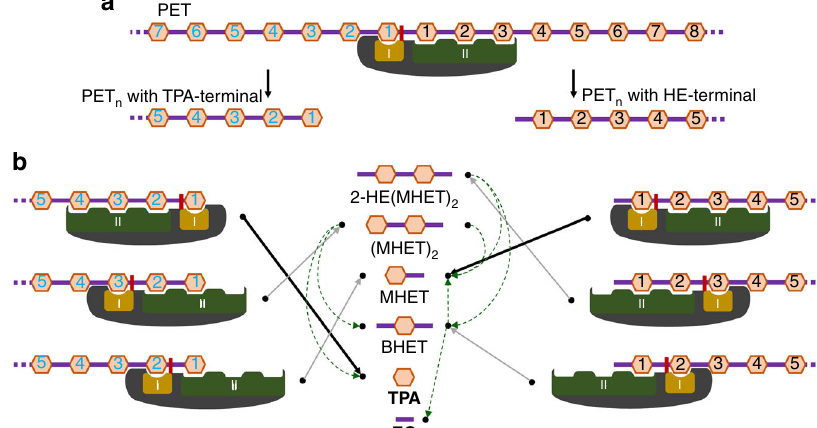
Fig. 4 Schematic diagram of PET degradation process. a Nick generation step. The TPA and EG moieties of the PET polymer are presented with orange- colored hexagons and purple-colored lines, respectively. Is PETase is shown with a dark-gray color diagram. Subsite I and subsite II of Is PETase are shown as an orange and green-colored diagrams, and labeled as I and II, respectively. The catalytic Ser160 residue is shown as a red-colored rectangle. The PET n polymers with the TPA-terminal and with the HE-terminal are labeled. The TPA moieties of these PET n polymers are labeled by numbers 1, 2, 3, 4, and 5 from each terminal. b Terminal digestion step. Each enzymatic reactions in terminal digestion step is shown as a diagram. The cleaved products from the enzymatic reactions are indicated with black-colored arrows. The light green-colored dotted lines indicate the paths the PET polymer products go for the next reaction. Six PET-related compounds, 2-HE(MHET) 2 , (MHET) 2 , MHET, TPA, BHET, and EG, that are cleaved products from terminal digestion step, are shown. The fi nal degradation product (MHET, TPA and EG) are labeled in